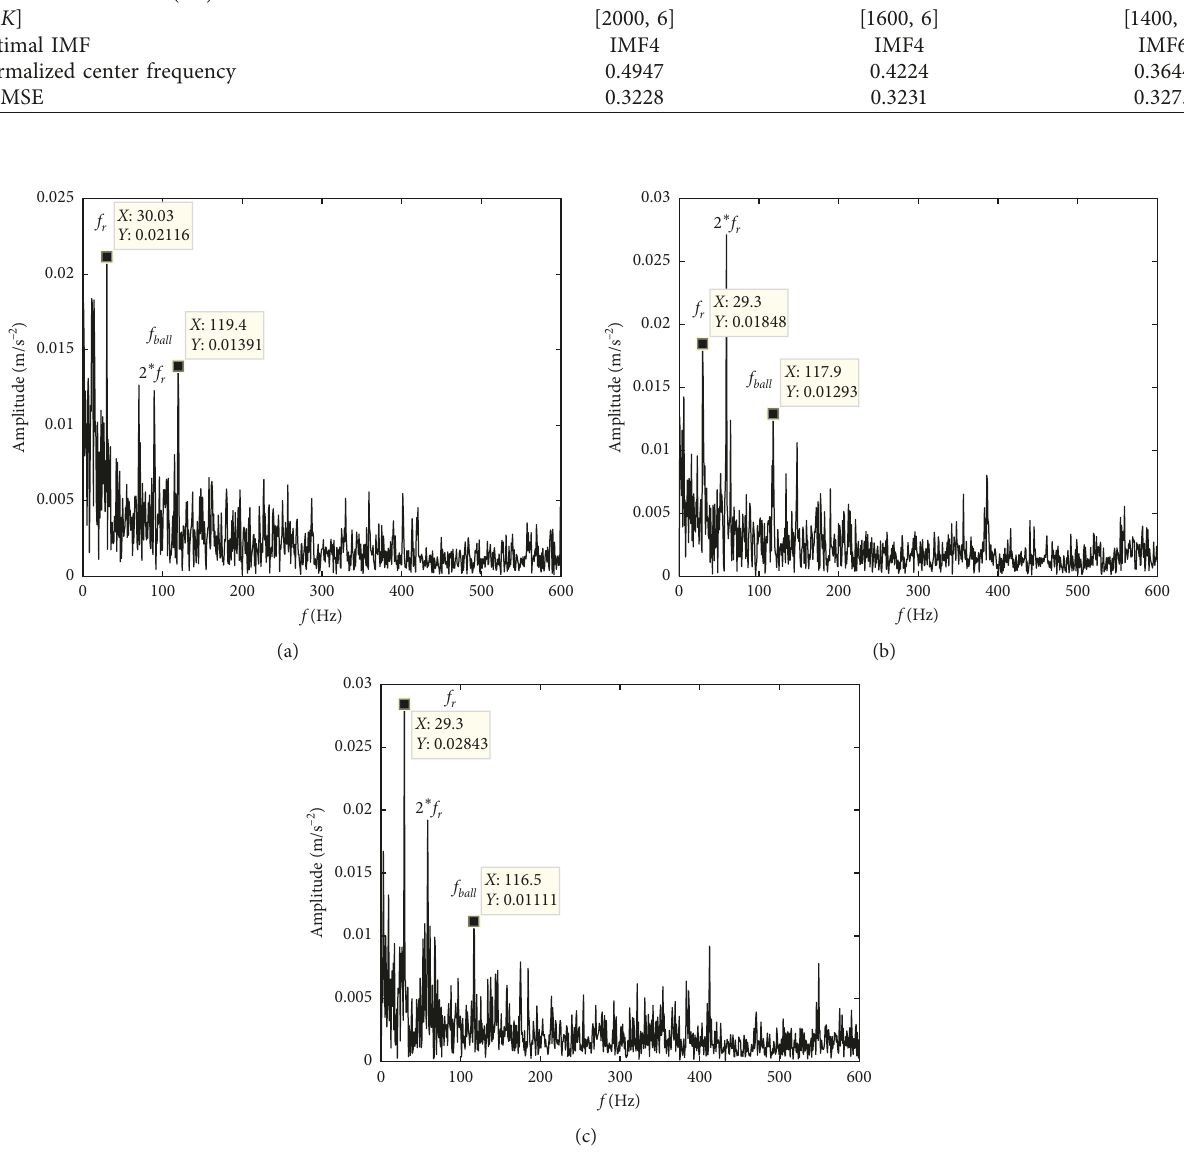
Figure 9: The best IMF component and its corresponding marginal spectrum and center frequency. Marginal spectrum of IMF4 components under load: (a) 0 hp; (b) 1hp; (c)